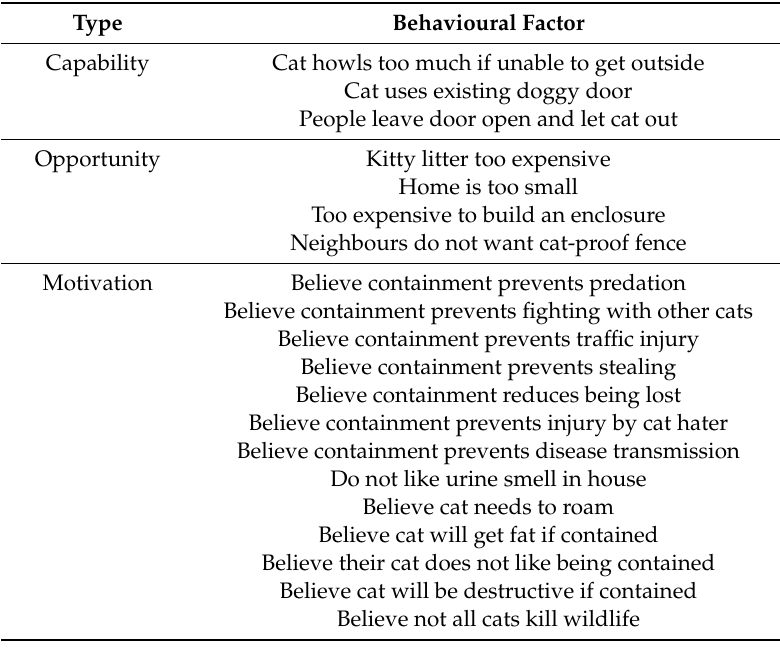
Table 1. The 20 potential behavioural factors influencing cat owners’ containment behaviour identified from the literature that were used in the